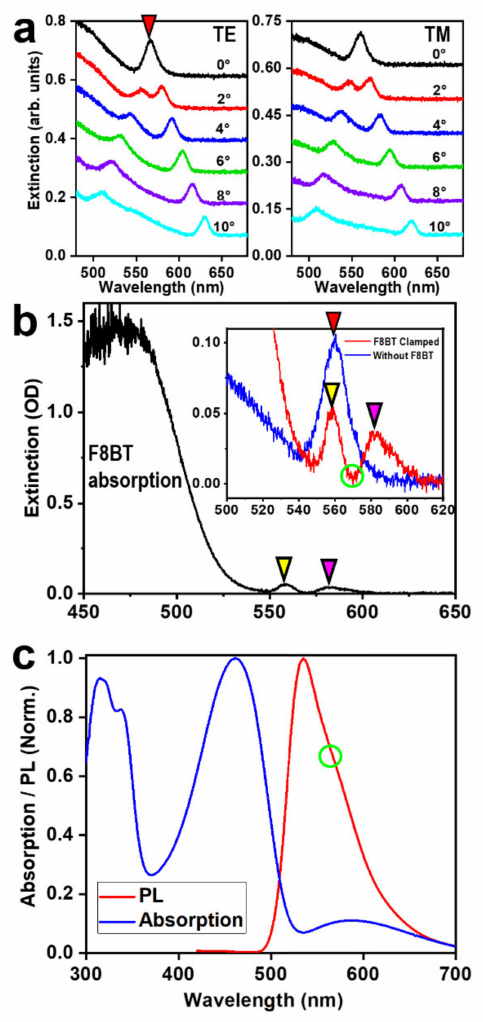
Figure 3. ( a ) Optical extinction spectra measured on the PR grating with a fused silica substrate at different angles of incidence (0~10 ◦ ) for TE ( left ) and TM ( right ) polarizations. ( b ) Optical extinction measurements on the microcavity formed through clamping the F8BT thin film and the PR grating by a face-to-face scheme, as shown in Figure 1a( 4 (cid:13) ). Inset: enlarged view of the waveguide resonance modes (red) and comparison with that measured on the pure PR grating (blue). ( c ) Absorption and PL spectra measured on a pure F8BT thin